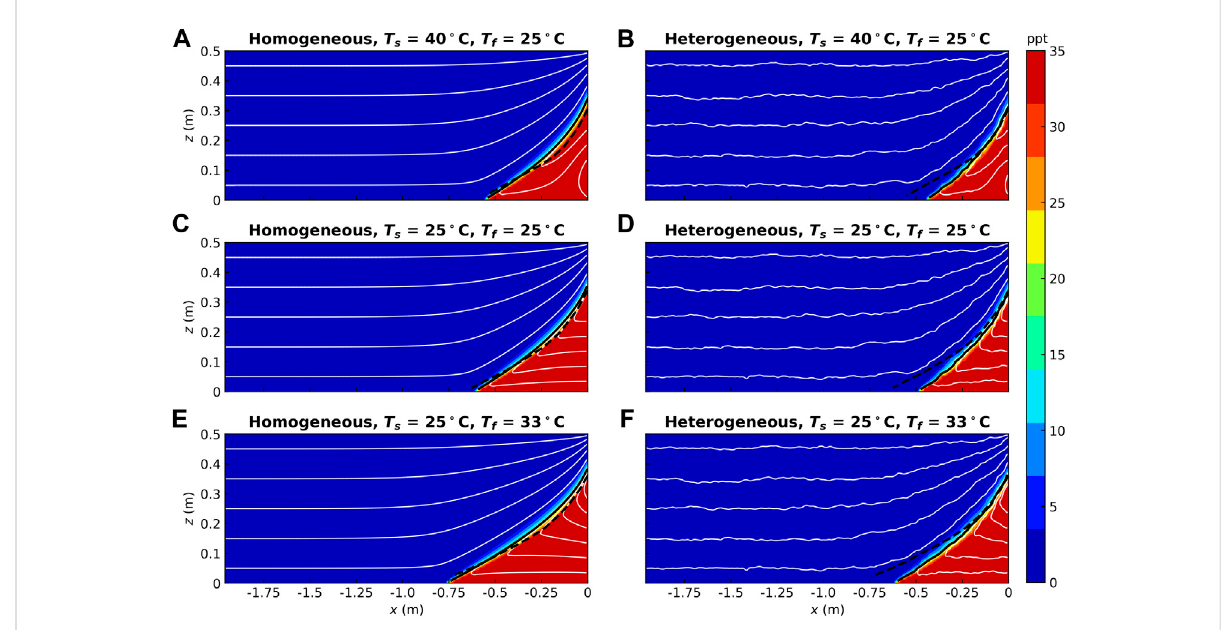
FIGURE 2 The laboratory-scale salinity distributions under different FW-SW temperature contrasts. The left-hand (A, C, E) and right-hand (B, D, F) panels are the results for homogeneous and heterogeneous aquifers, respectively. The black solid and dashed lines are, respectively, for the 50% seawater concentration isohalines (17.5 ppt) and the measured (Pu et al., 2020) freshwater-seawater interface (FSI). The white lines show fl ow streamlines. T s and T f are seawater and freshwater temperatures,